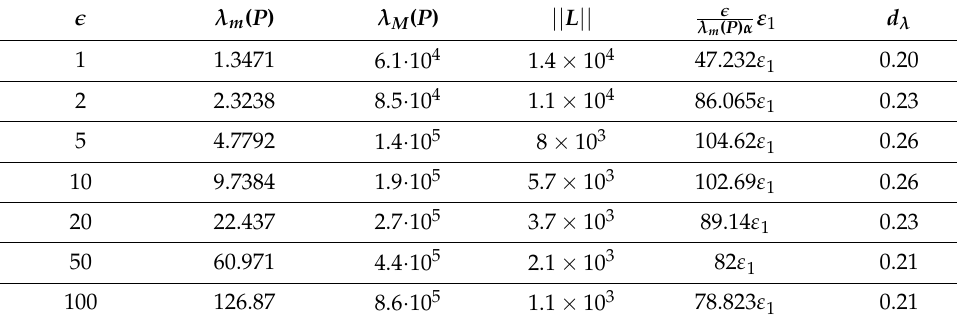
Table 4. Solutions of LMI (16) for the constant α = 1 and various (cid:101)